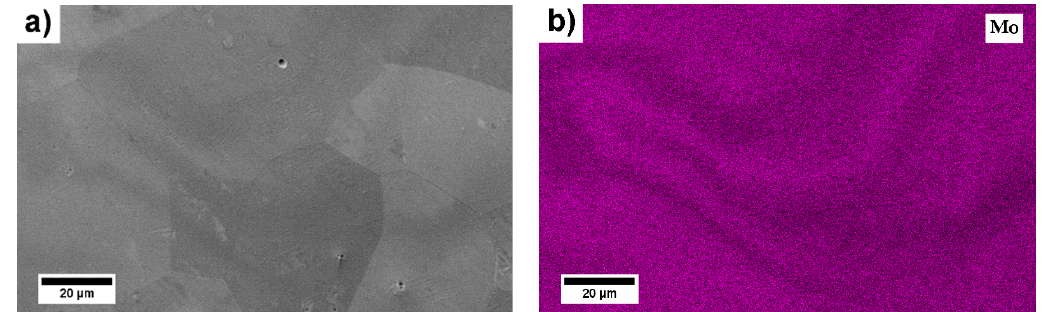
Figure 2. Local chemical inhomogeneities in ST Ti15Mo alloy: ( a ) scanning electron microscopy– secondary electrons (SEM–SE) micrograph of the area of interest, ( b ) corresponding element map of Mo using EDS.